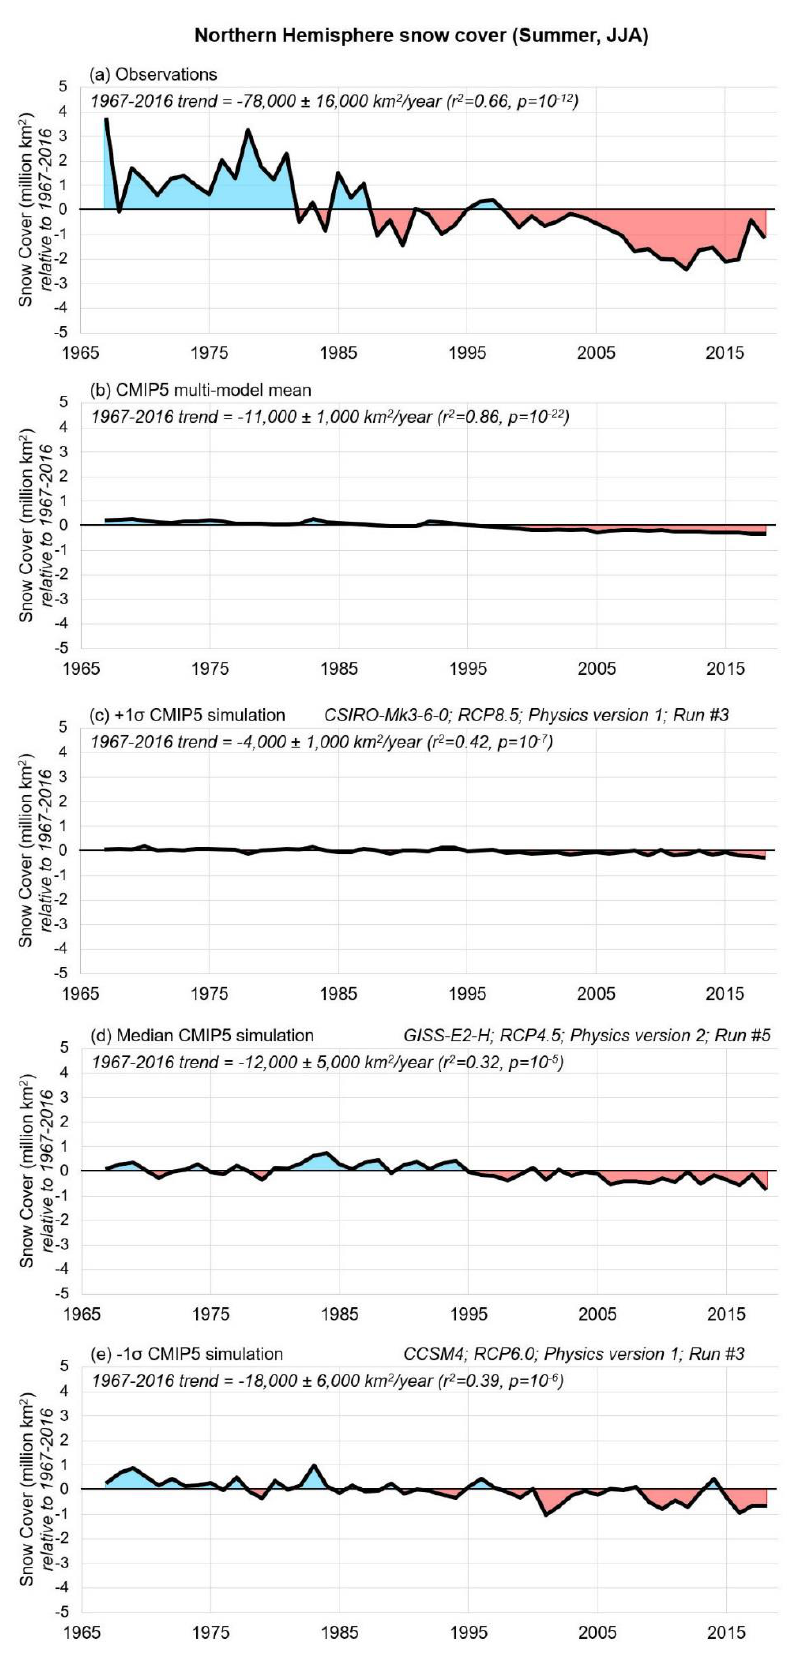
Figure 7. Same as Figure 4, except showing the summer (JJA, i.e., June, July and August).